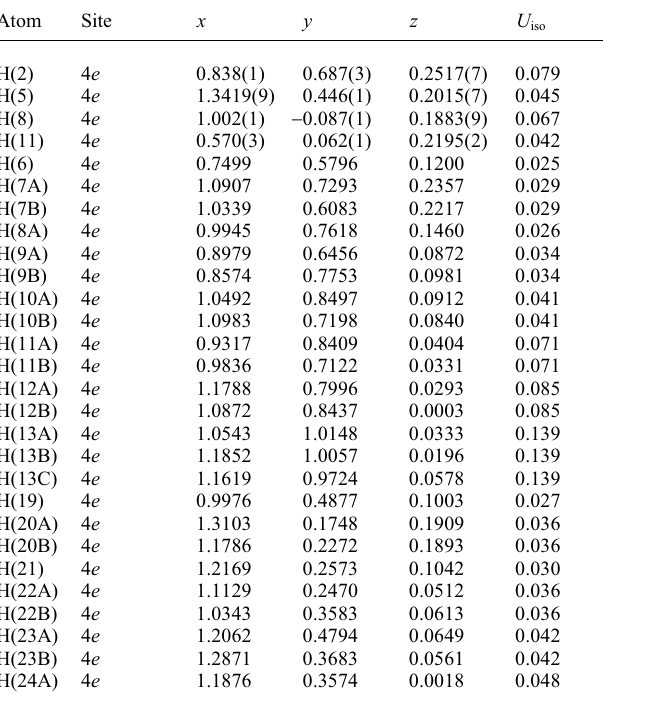
Table 3. Atomic coordinates and displacement parameters (in Å 2 )